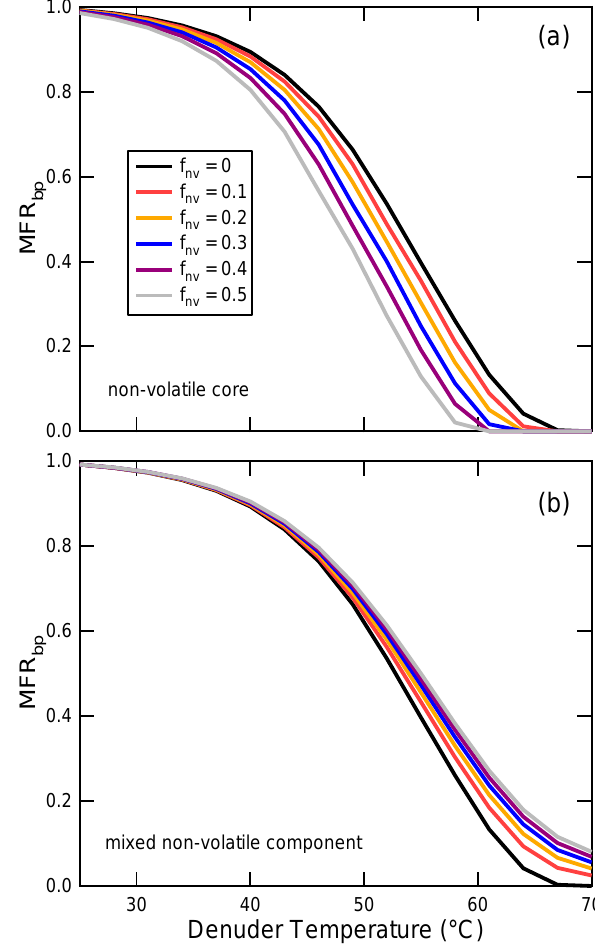
Fig. 11. (a) The MFR bp vs. T d is shown for particles where it is assumed that a non-volatile core comprising varying frac- tions of the total particle mass ( f nv ) is included. The calcula- tions used C sat =1µg/m 3 , C OA =10µg/m 3 , 1H vap =120kJ/mol and d p =200nm. (b) Same as (a), but for the condition where the non- volatile fraction participates in absorptive partitioning, i.e. is well- mixed with the volatile component. Here, the initial mass loading of the volatile component is fixed at 10µg/m 3